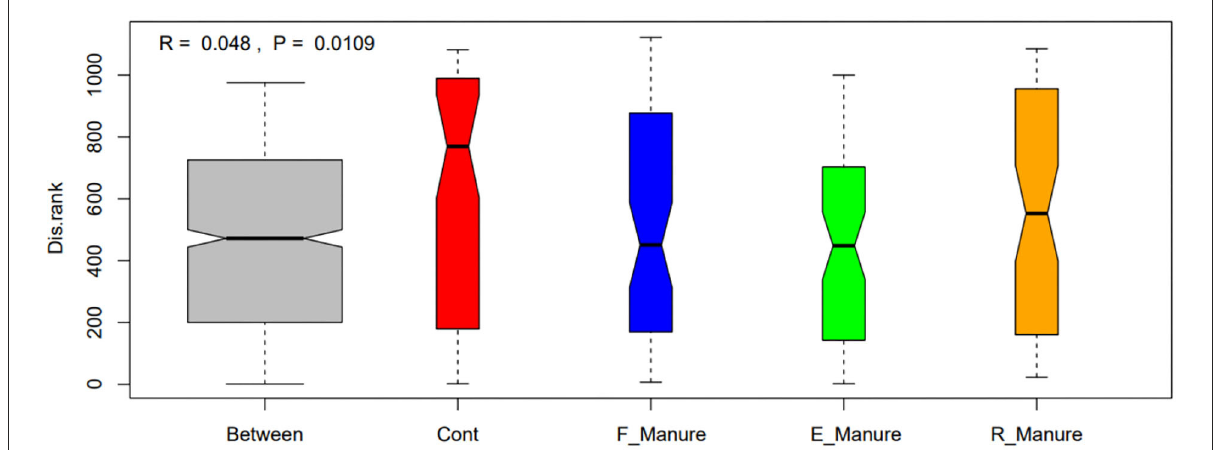
FIGURE2 The beta dispersion of bacterial communities in the four treatments of fertilization by box plot illustration. Significant differences between treatments of fertilization were tested by ANOSIM and are indicated by the value range of R -value (anosim statistical R) and P -value (significance). R -value is ( − 1,1). R > 0 indicating that the difference between groups is greater than that within groups, that is, the difference between groups is significant; R < 0 indicating that the difference within the group is greater than that between the groups. The greater the absolute value of R , the greater the relative difference. The lower the p -value, the more significant the difference in test result is. Generally, 0.05 is the significance level limit. Boxes represent the interquartile range (IQR), and whiskers indicate the furthest point within 1.5 × IQR above or below the IQR. Values beyond this range are plotted as individual points. The central line indicates the median.